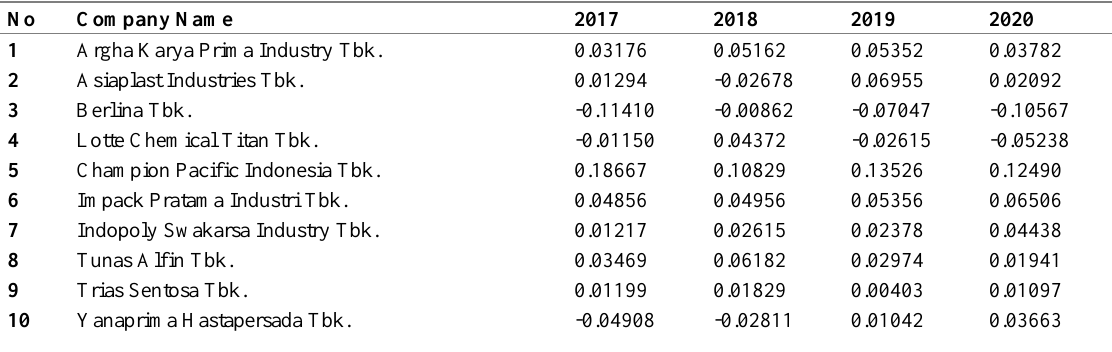
Table 3: Earnings Before Interest and Taxes to Total Assets of Sample Companies